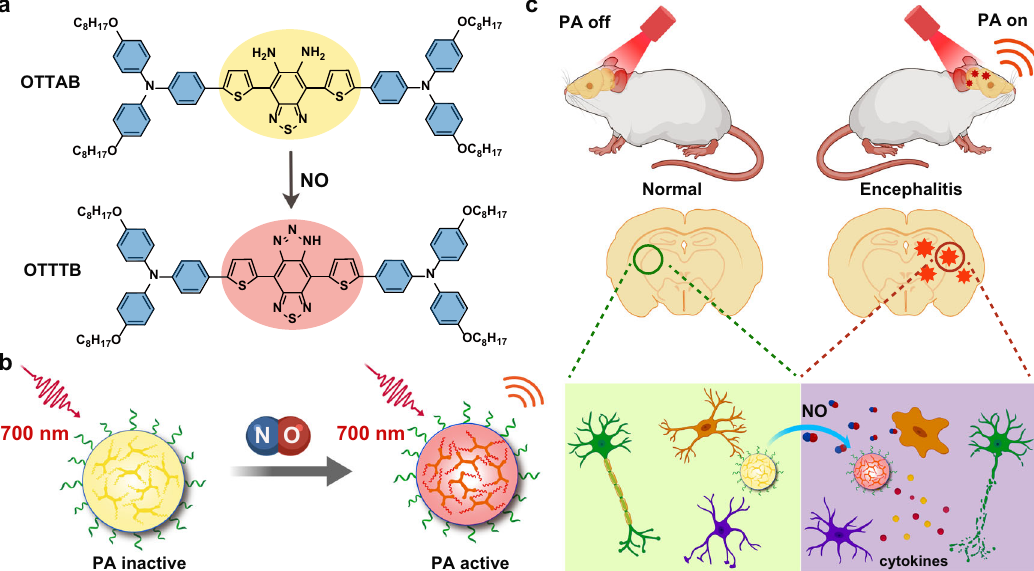
Fig. 1 Turn-on PA probe for NO detection in vivo. a Changes of chemical structures and b NPs property after NO treatment. c Schematic illustration of the in vivo detection of encephalitis with the turn-on PA probe. The illustrations were created with the help of